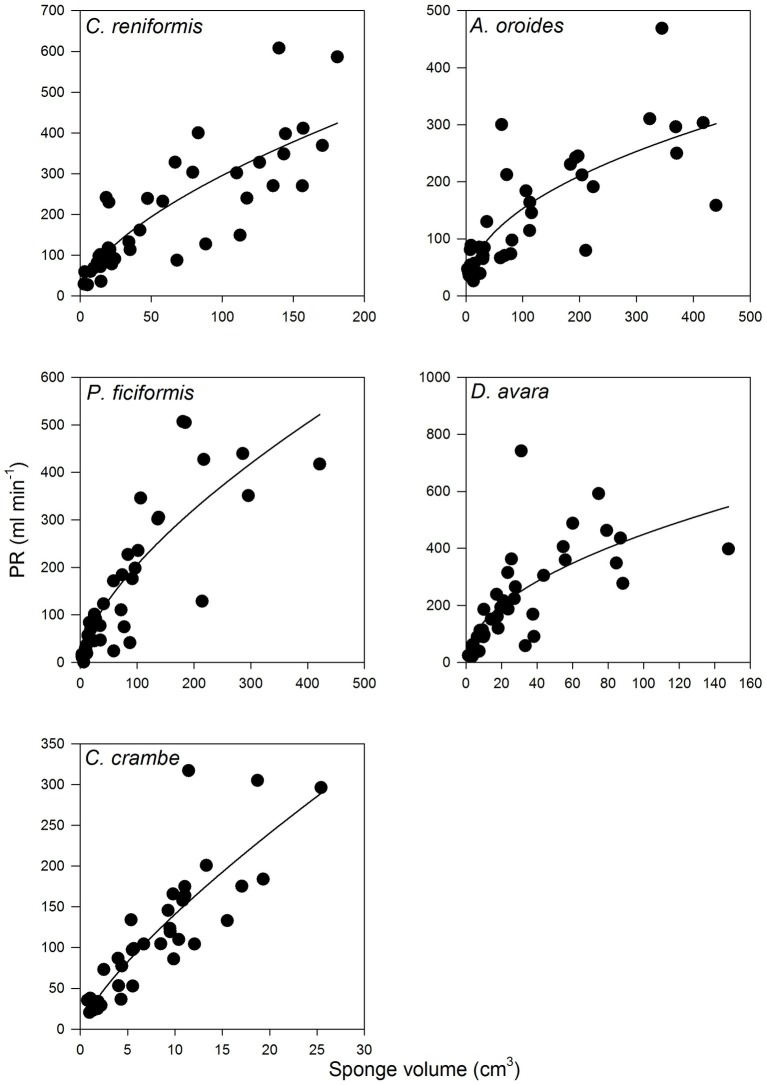
The relationships between the sponge pumping rate (PR, ml min−1) and its volume (cm3) for multi-osculated specimens. The equations of the regression lines are shown in Table 3.